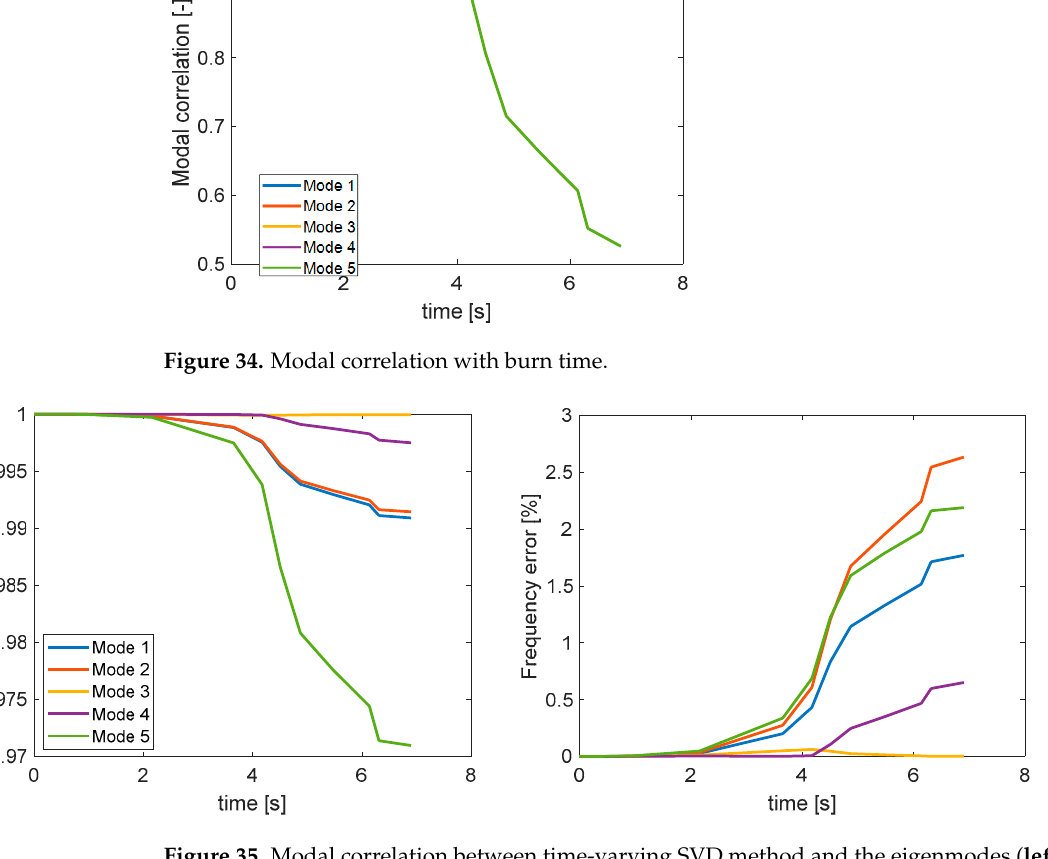
Figure 36. Representation of deflected rocket at a scale factor of 50.